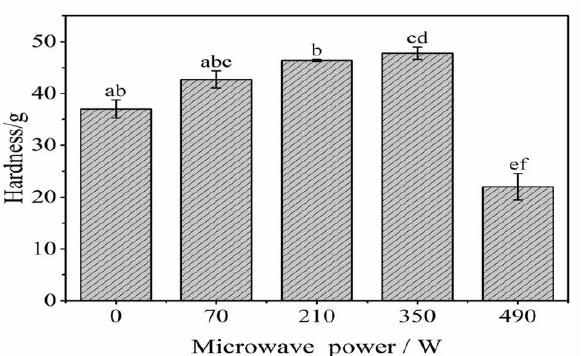
Figure 2. Effect of microwave power on the hardness of lysozyme-oregano essential oil (LZ-OEO) bacteriostatic gels. Different letters of a–f refer to statistically significant differences among the values (p < 0.05).